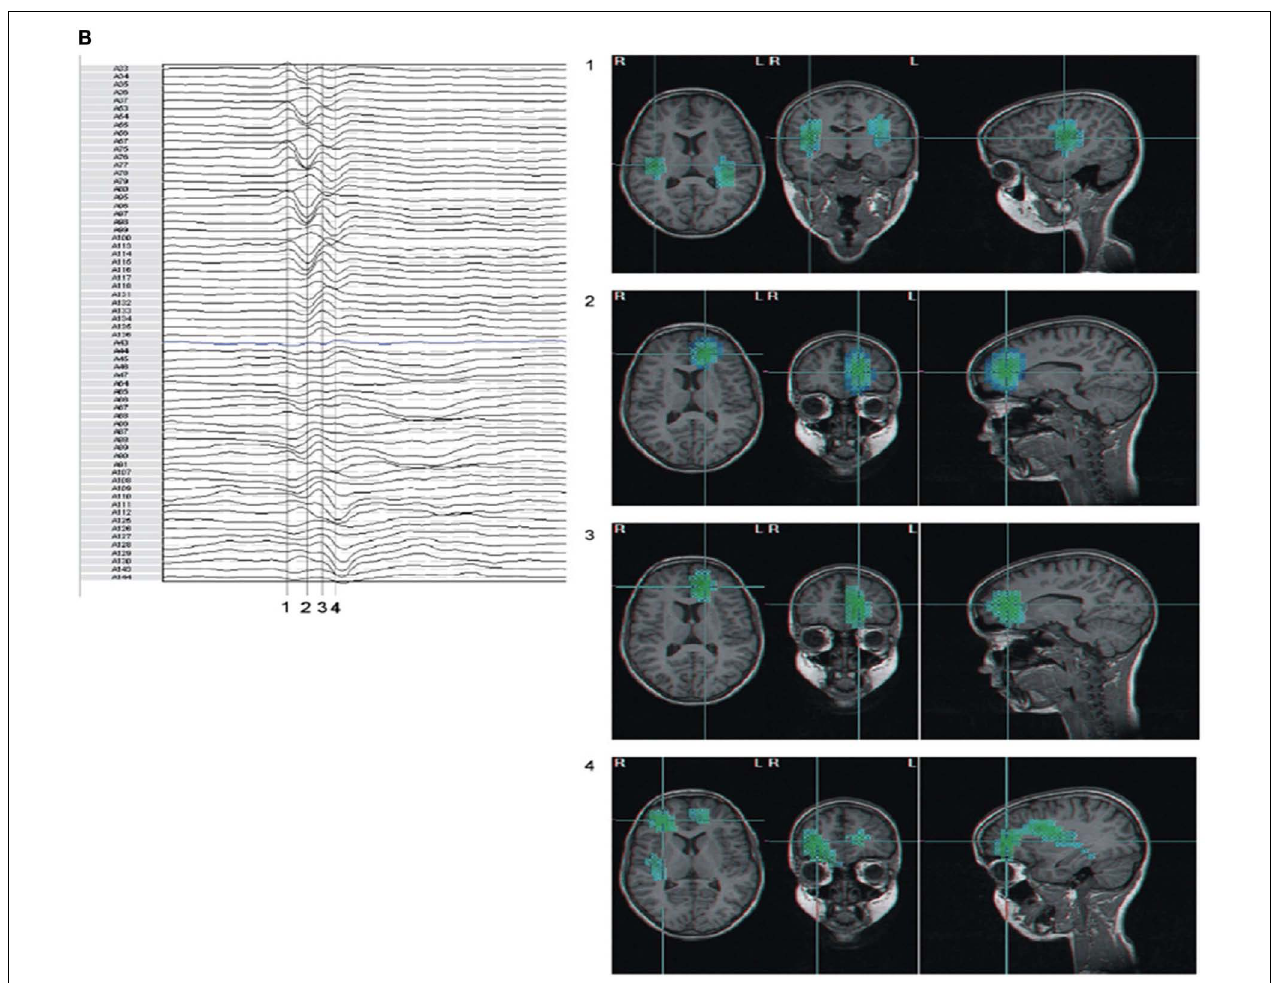
polar and basal, bilateral frontal, and subsequently to perisylvian areas; (B) in parts reversed propagation sequence compared to (A) : bilateral perisylvian origin, propagation to left frontal mesial, and subsequent involvement of bilateral frontal areas. (For interpretation of the references to color in this figure legend, the reader is referred to the web version of the article; Stefan et al.,